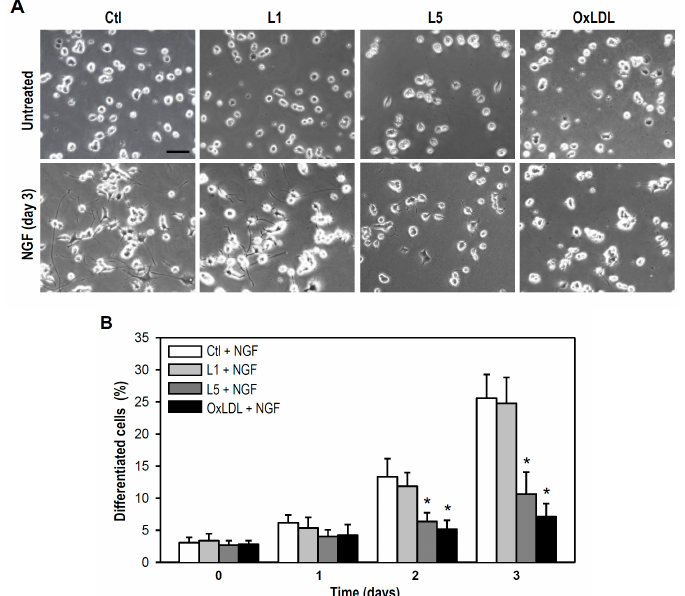
Figure 5. L5 inhibits NGF-induced neuronal differentiation of cultured PC12 cells. ( A ) Representative photos show PC12 cells treated with the indicated LDLs (10 µ g/mL) in the absence or presence of NGF (50 ng/mL) for 3 days. Cells untreated with LDLs were used as a control. NGF-induced neuronal differentiation is indicated by the extent of neurite outgrowth. Scale bar = 50 µ m; and ( B ) The percentage of neuronal differentiation in PC12 cells exposed to LDLs (10 µ g/mL) plus NGF (50 ng/mL) for 1, 2, and 3 days was determined by calculating the number of cells (% of total) bearing neurites longer than one cell body in diameter. Ten randomly selected fields were examined and at least 300 cells were counted for each treatment group at each time point. Data are presented as mean ± SEM of one representative experiment; two other experiments revealed consistent results. * p < 0.05 vs. Ctl + NGF at the same time